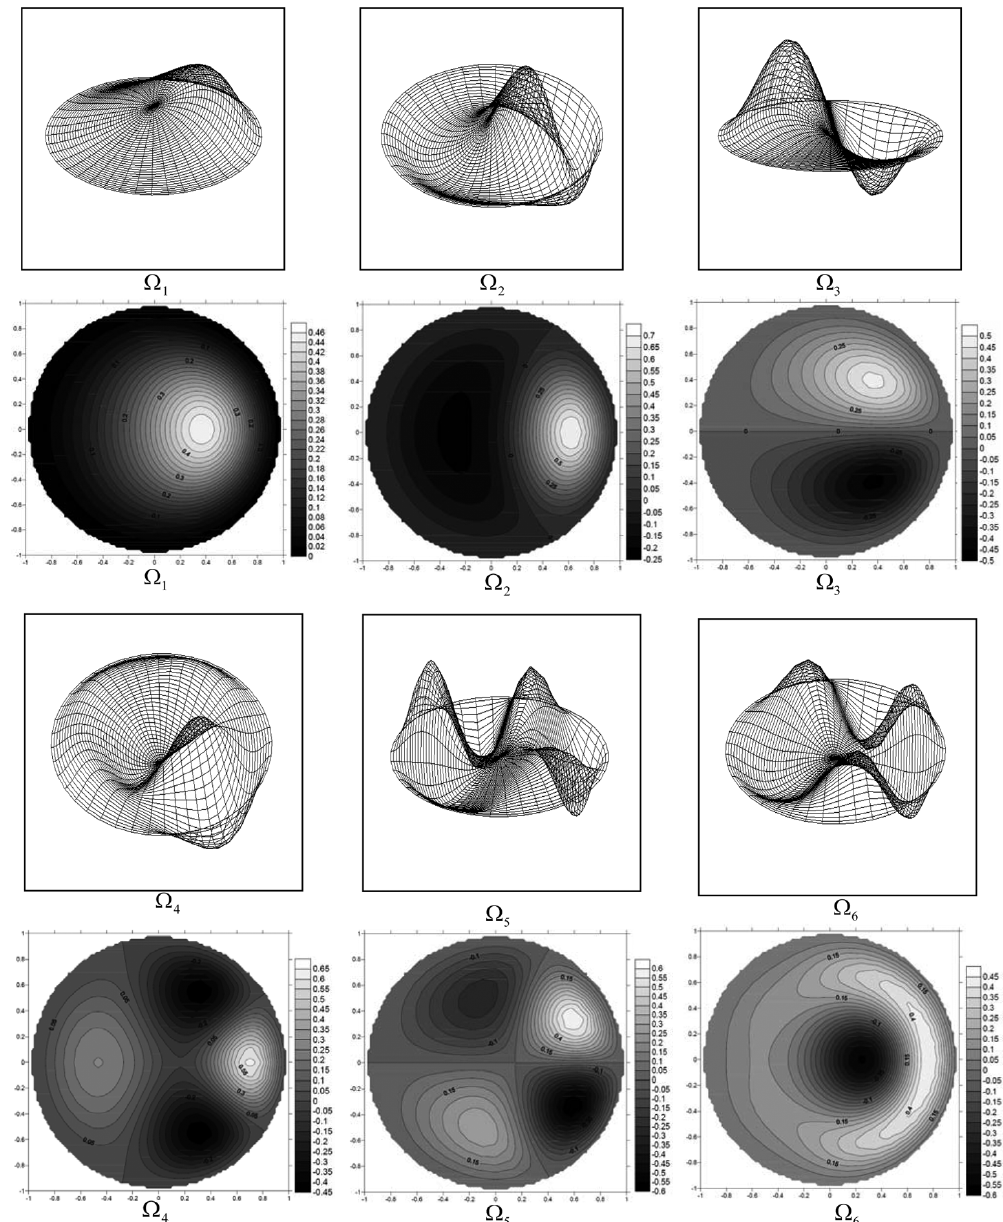
Fig. 5. First six normal modes and their contours for C-plates when α = β = 0.5 and k =